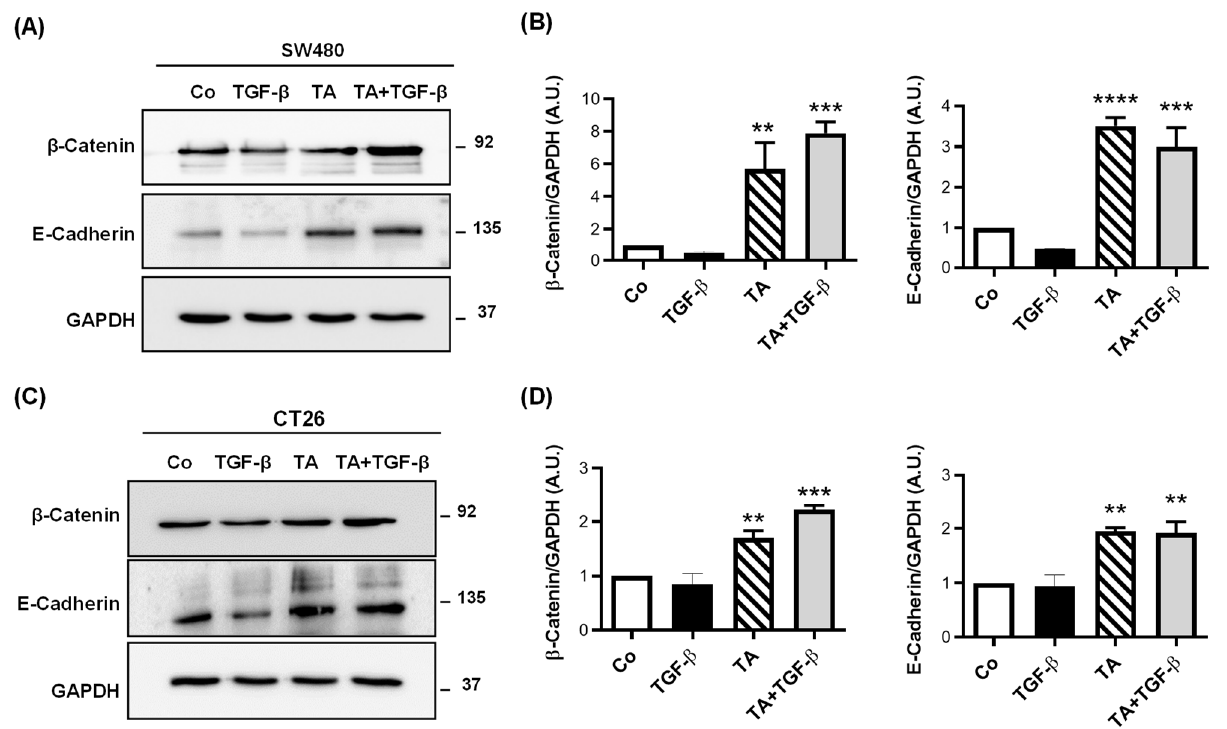
Figure 5. TA inhibits the TGF- β -induced decrease in epithelial marker expression in SW480 and CT26 cells. Serum-starved SW480 and CT26 cells were treated with TA (0.8 µ M), TGF- β (10 ng/mL), or a combination of both (TA + TGF- β ) for 48 h. Vehicle-treated cells served as the control (Co). Representative immunoblot and densitometry quantification analysis of EMT markers β -catenin and E-cadherin in SW480 ( A , B ) and CT26 ( C , D ) after 48 h of treatments. The band intensity was quantified using GAPDH as an internal loading control, and quantification values were normalized to the control. Results are expressed as mean ± SD of 3 independent experiments (n = 3). Statistical